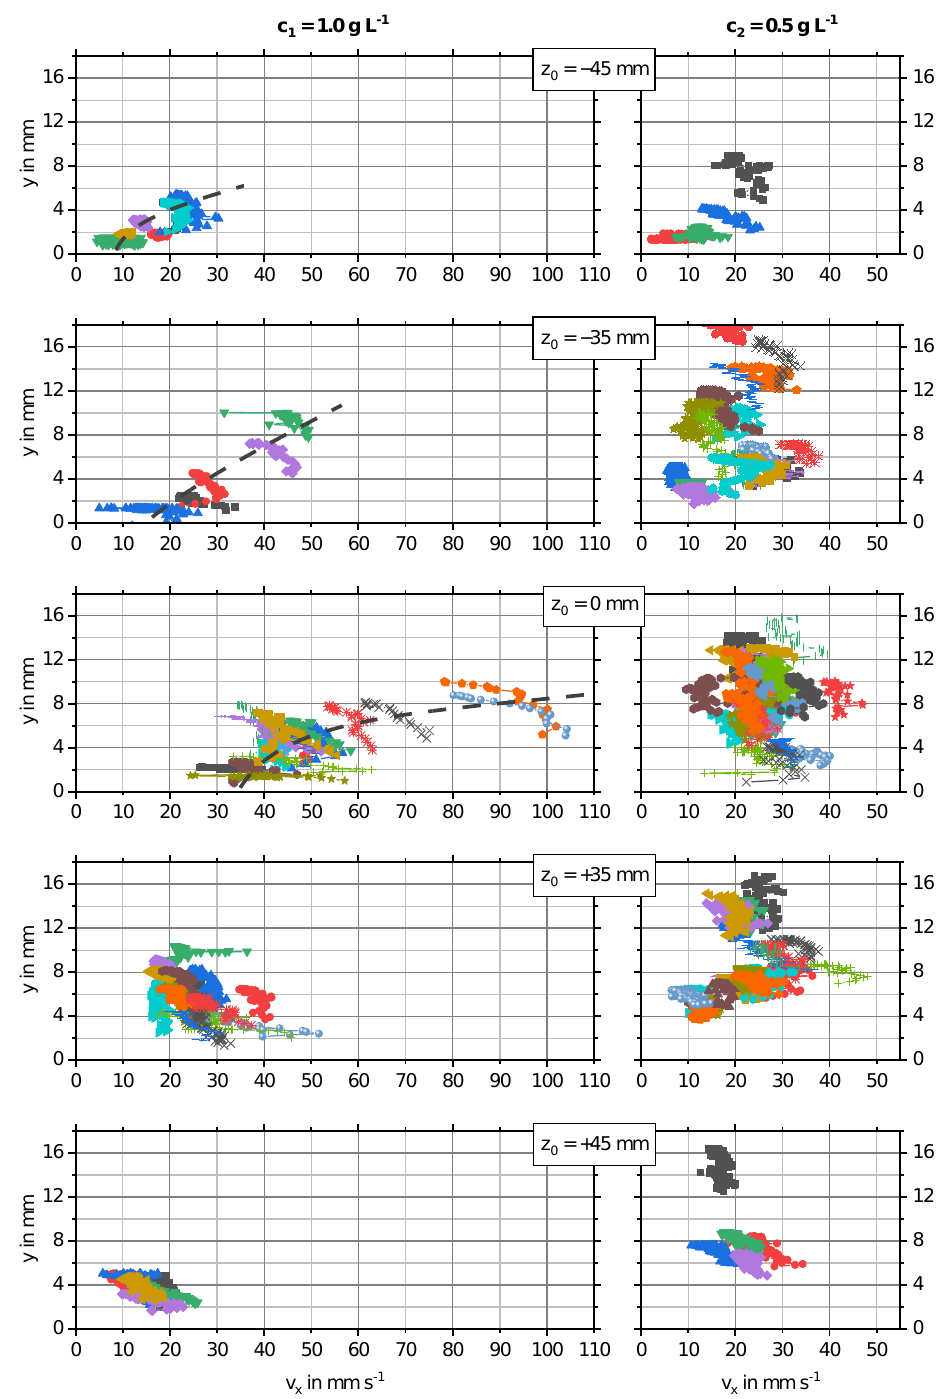
Figure 10. Tracer particles in different measuring planes z 0 at the weir: the horizontal velocity component v x is plotted against the vertical position y above the weir. In the case of the foam at the higher surfactant concentration ( c 1 = 1.0gL − 1 , plots on the left), the velocity gradients from the centre of the flow channel ( z 0 = 0mm) towards its left ( z 0 = + 45mm) or right side wall ( z 0 = − 45mm) are more pronounced than at the lower concentration ( c 2 = 0.5gL − 1 , plots on the right). The positive velocity gradient dv x / dy > 0 in the vertical direction, which was clearly identified in the measuring planes z 0 = [ 0 mm; − 35 mm; − 45 mm ] at c 1 = 1.0gL − 1 , is emphasised by the grey dashed trend line in the respective plots. Each symbol and colour indicates one tracer